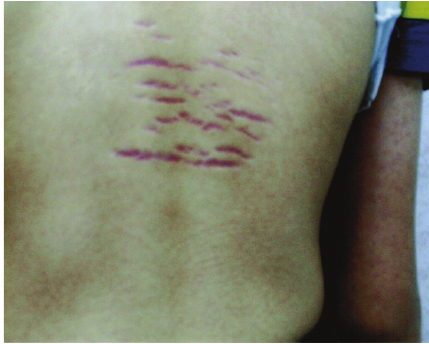
Figure 1: Multiple purplish, atrophic, horizontal linear striae on the upper